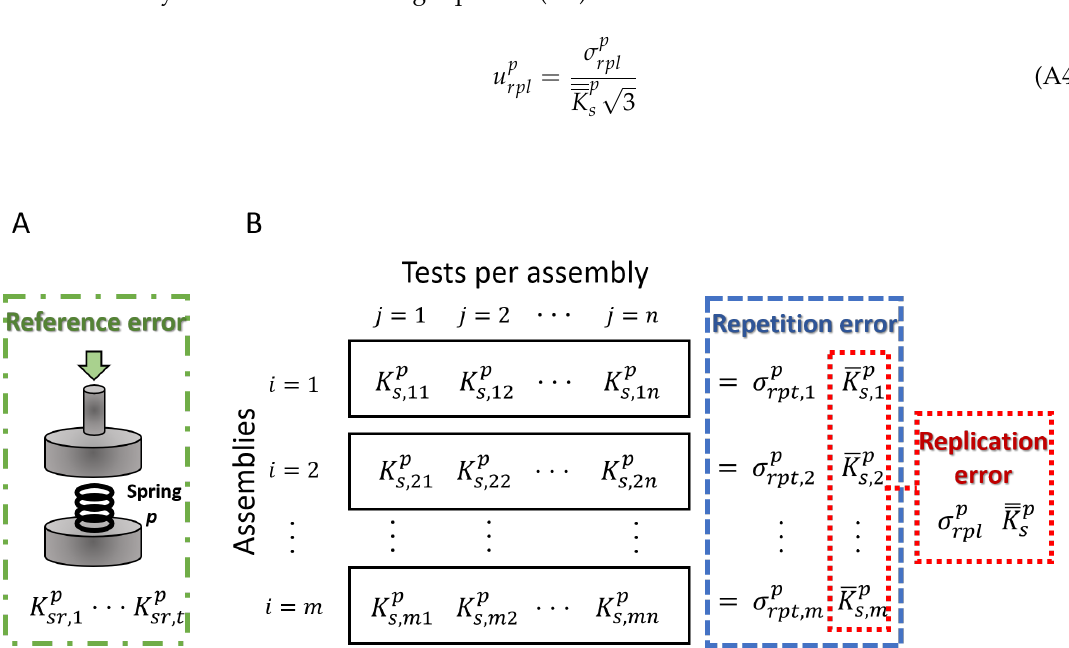
Figure A3. Scheme of the in vitro tests performed on the elastic spring by means of the push-pull machine for uncertainty calculations. ( A ) Direct tests on the elastic springs for the reference uncertainty calculation. ( B ) Tests with the spring placed inside the sheep metatarsus in several fixation assemblies for the replication and repetition uncertainty